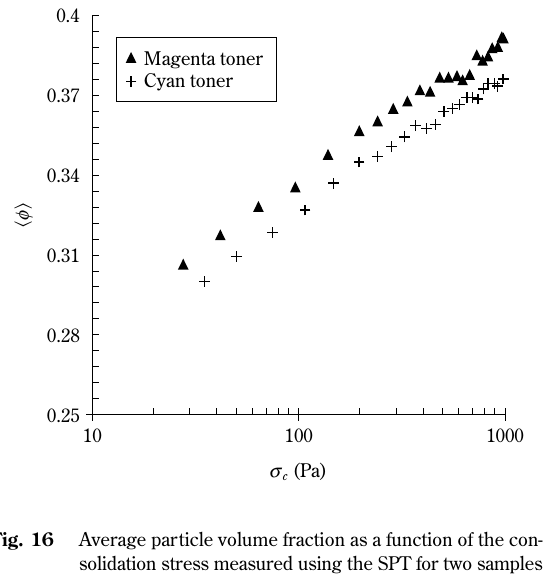
Average particle volume fraction as a function of the con- solidation stress measured using the SPT for two samples of different color (magenta and cyan) of the commercial xerographic toner Canon CLC700.